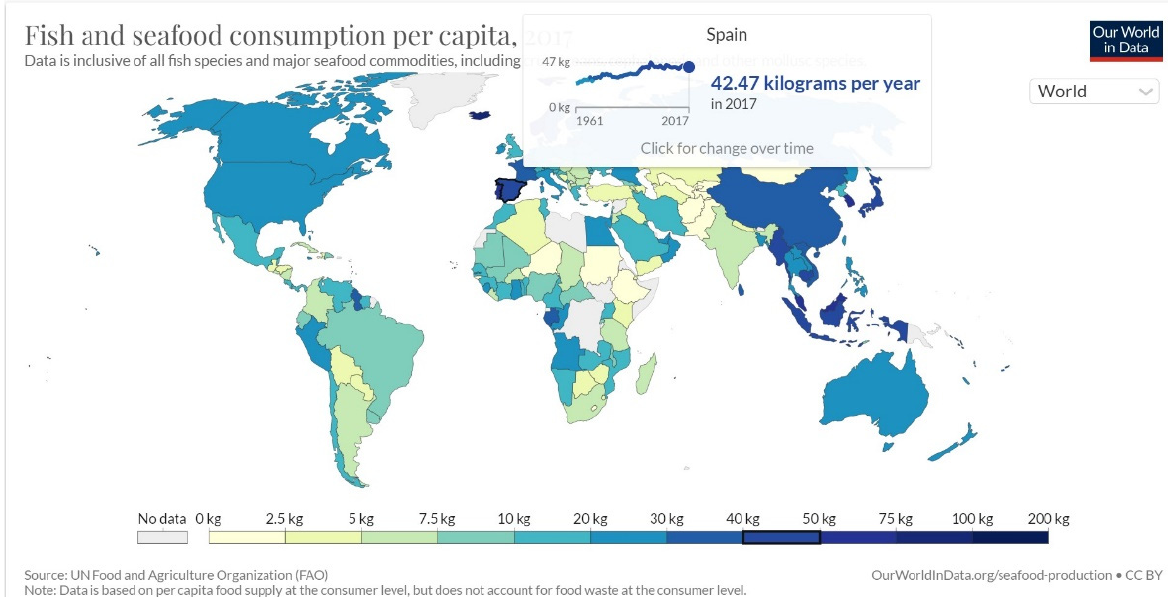
Figure 9. Fish and seafood consumption per capita, and per year in Spain. Adapted from Ref. [22].